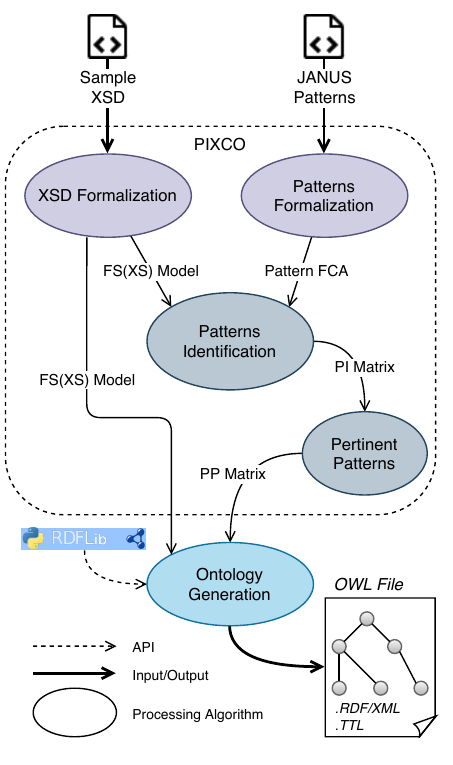
Figure 1. OGGD Architecture